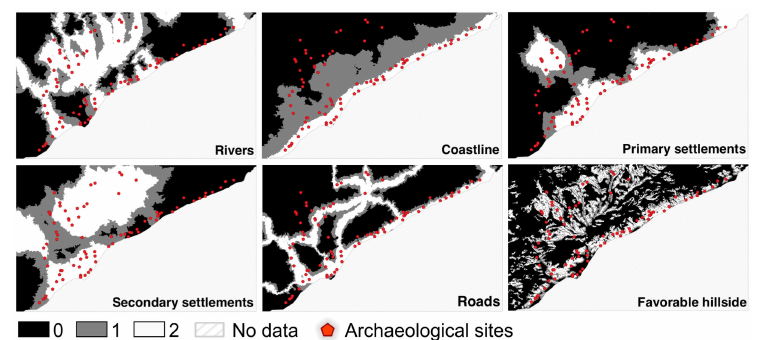
Figure 5. Rasters of the reclassified cost distance predictor variables.